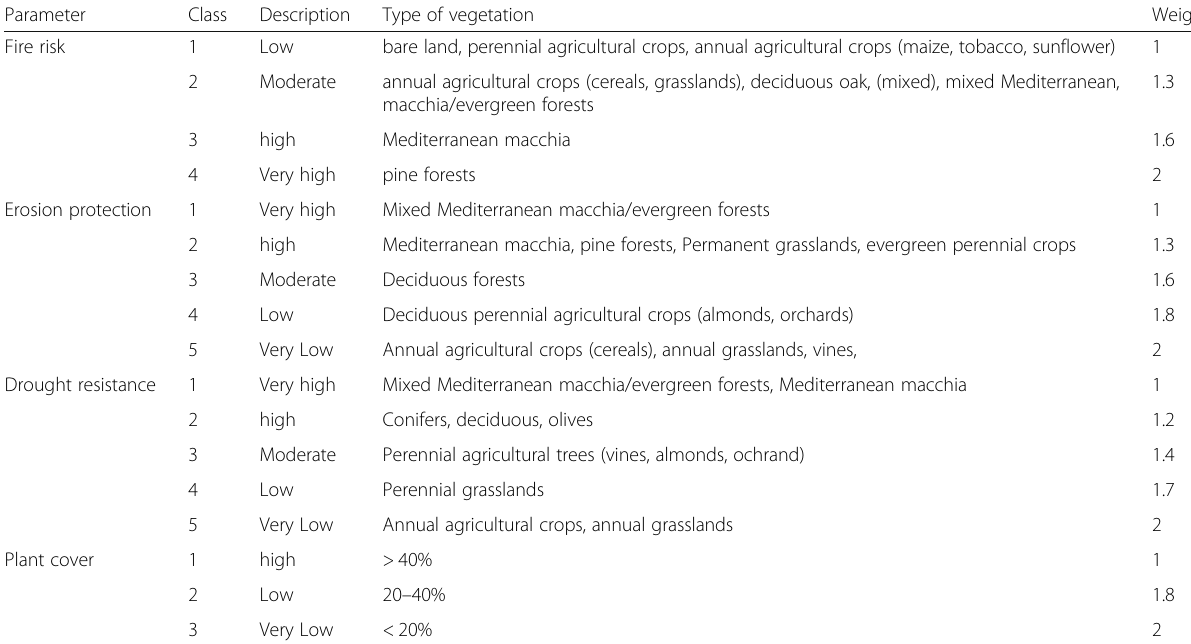
Fig. 5 Land use in study area Table 6 Assigned weighing indices for various parameters used for assessment of vegetation quality (Kosmas et al. 1999)